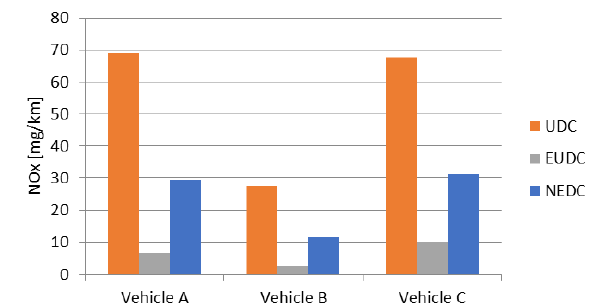
Fig. 5. Nitrogen oxides emissions in NEDC test and its particular stages